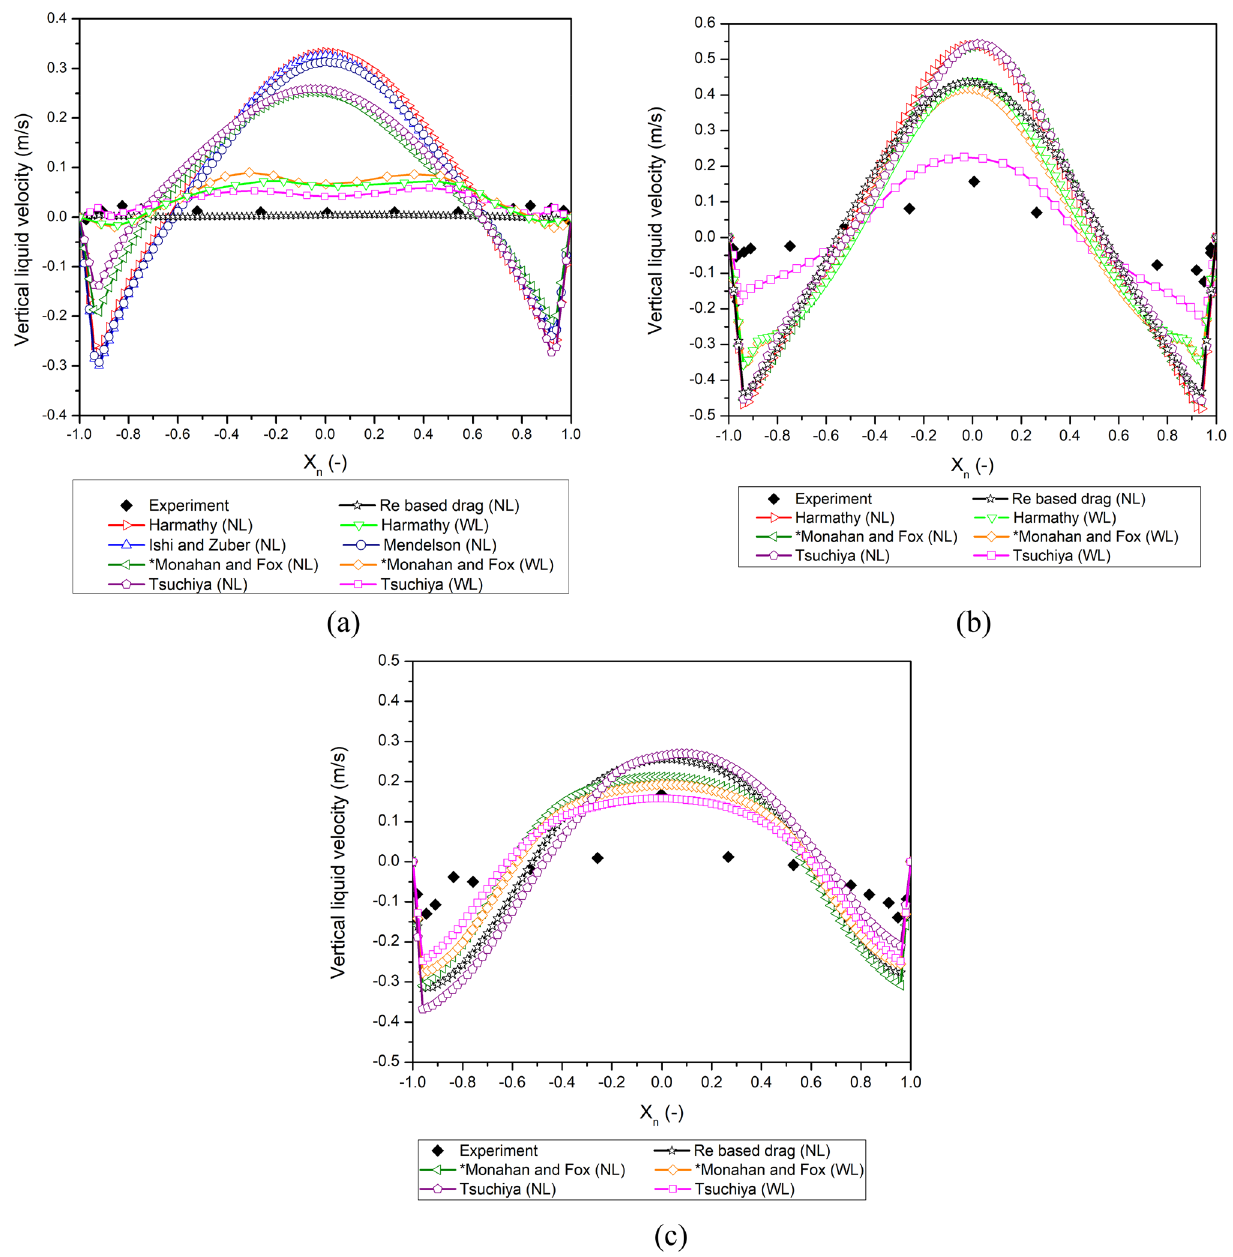
Fig. 5 Effect of different drag and lift closures on time-averaged vertical liquid velocity for a A1 (100%), A4 (69%) and c A7 (18%) sparger at U = 2.9 cm/s ( * drag used by Monahan and G